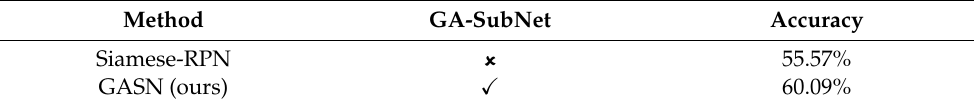
Figure 12. Pectin-PEGMA solution turned white after the addition of α -CD: ( a ) original 10% P-10K solution; and ( b ) 10% P-10K solution after the addition of α -CD